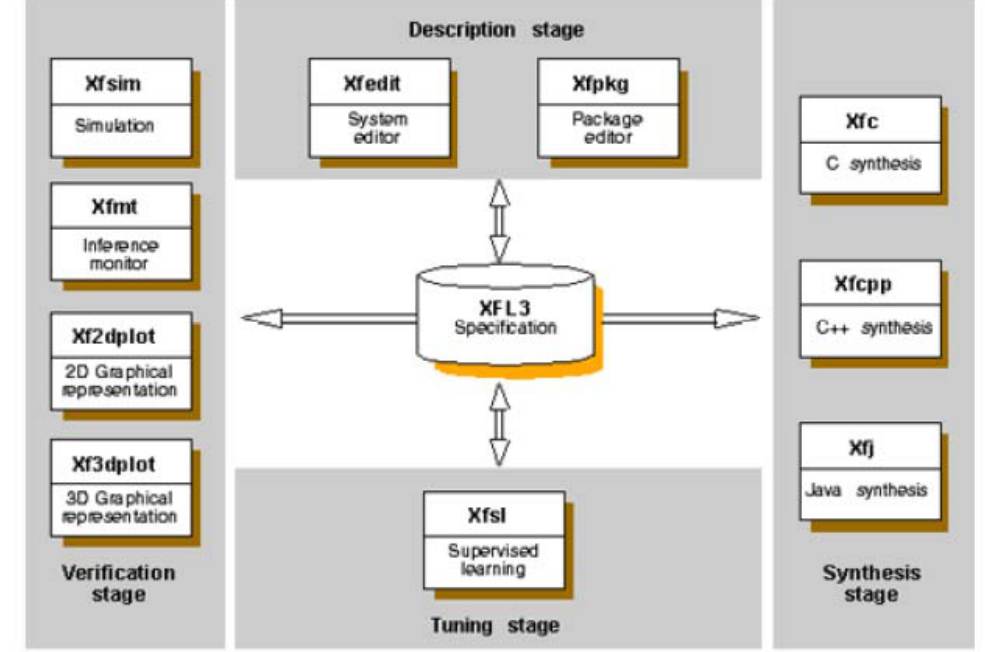
Fig. 4: Overview of